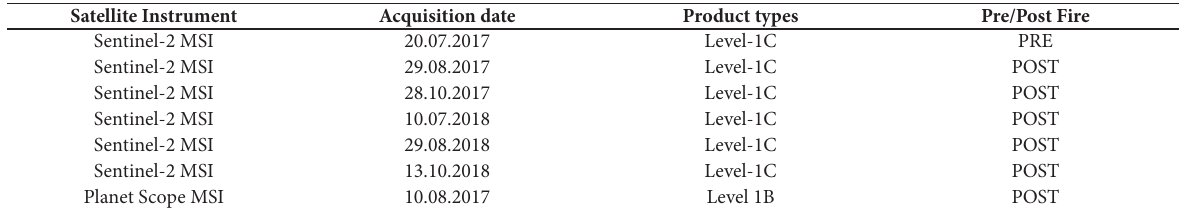
Table A1. Satellite images used for the analysis. Satellite Instrument